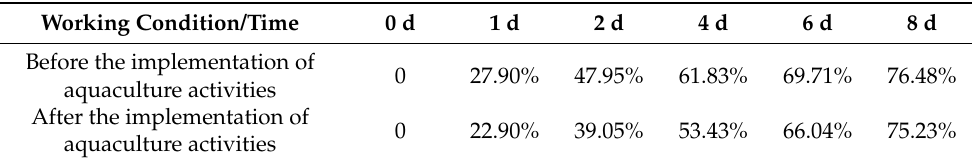
Table 4. Statistics for the water exchange rate–time curves before and after the implementation of